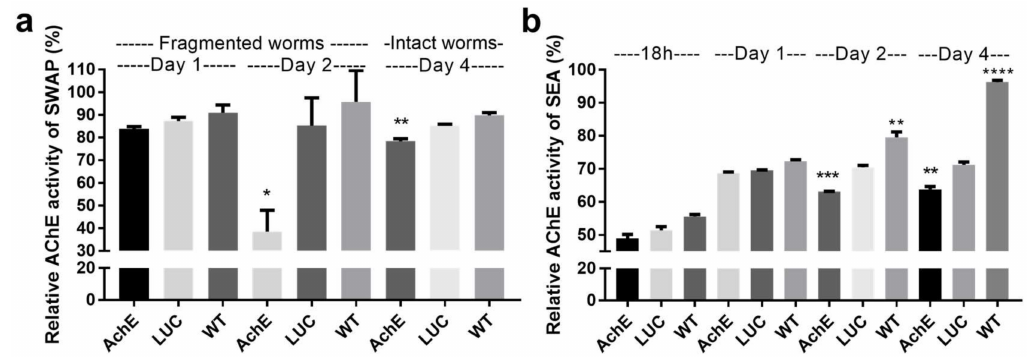
Figure 3. AChE activity of adult S. japonicum and eggs after treatment with SjAChE dsRNAs at different time points. ( a ) AChE activity of fragmented adult S. japonicum on days 1 and 2 and AChE activity of intact adults after treatment with SjAChE dsRNAs on days 4; ( b ) AChE activity of S. japonicum eggs after treatment with SjAChE dsRNAs at 18 h and 1, 2, and 4 days. Data are representative of the mean ± SEM of three separate experiments. p values were determined using t -tests to compare the differences between the luciferase RNAi control group and each RNAi group or each WT control group. * = p value ≤ 0.05, ** = p value ≤ 0.001, *** = p value ≤